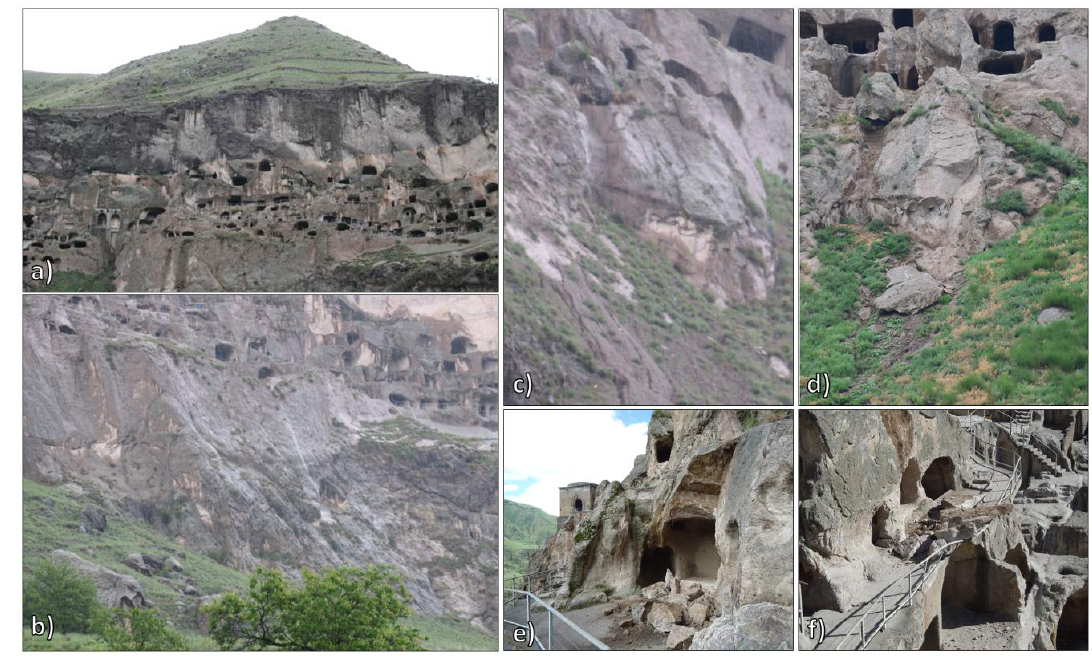
Figure 14. Conservation criticalities due to water runoff-infiltration: intense water runoff during a rainfall event in 23 May 2014 on the slope face ( a ) and slope toe ( b ) (courtesy of the director of the site), detail of collapsed block in AOI5 ( c : before the collapse – photo taken on 25 May 2015) and after the collapse ( d ). Details of rock collapses occurred after rainfall events: 11 July 2016 ( e ) and 19 September 2016 ( f ).